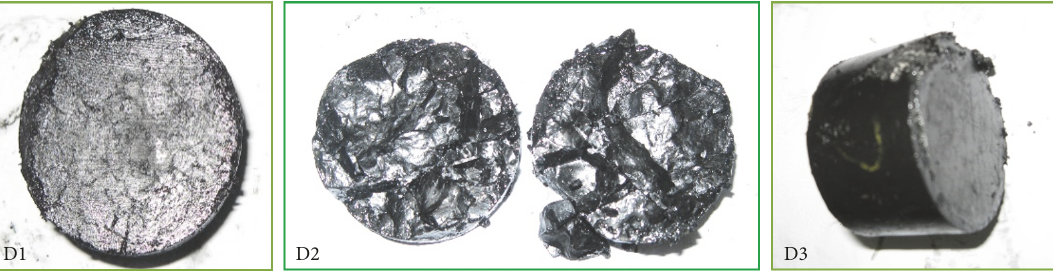
Figure 17: Failure forms of natural and water-saturated specimens under triaxial static-dynamic